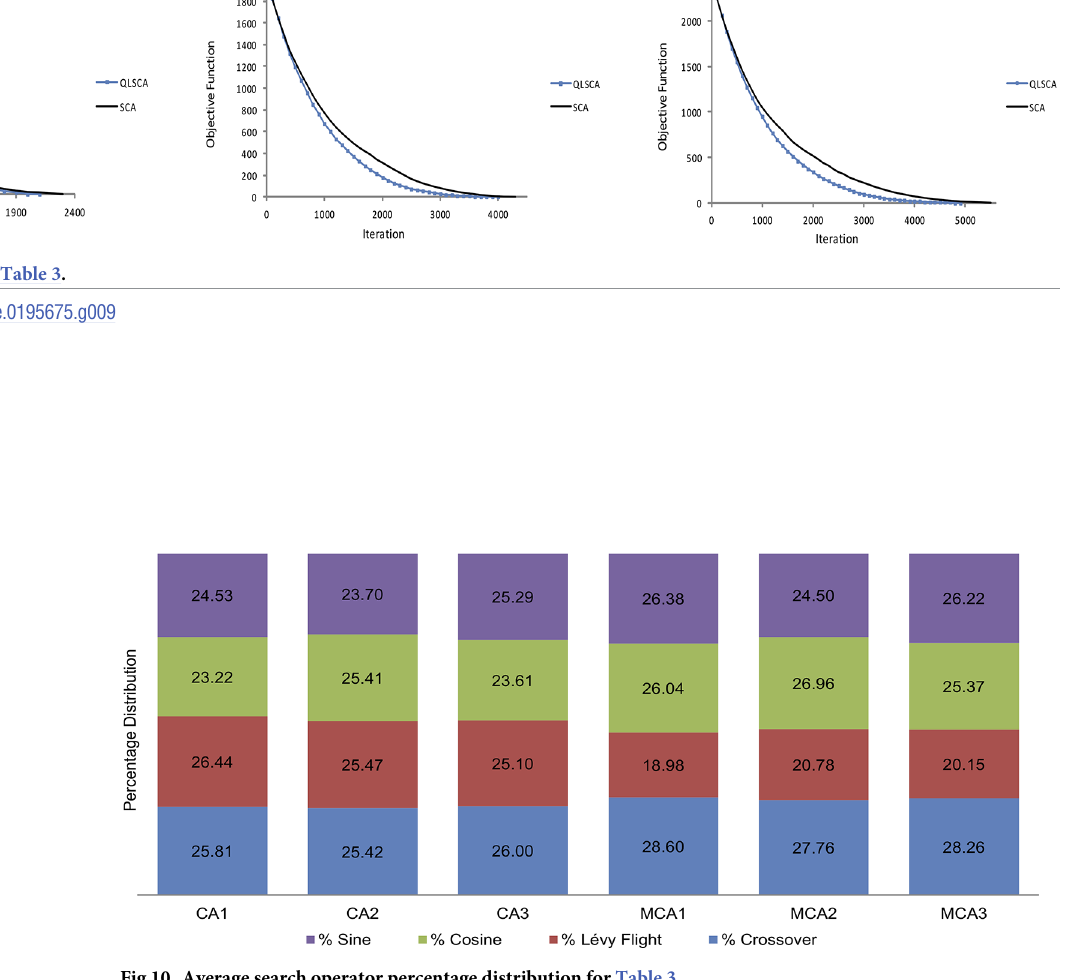
PLOS ONE | https://doi.org/10.1371/journal.pone.0195675 May 17,